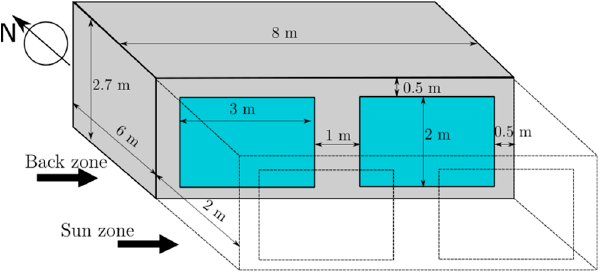
Figure 4. The reference building geometry indicated by BESTEST for software verification.